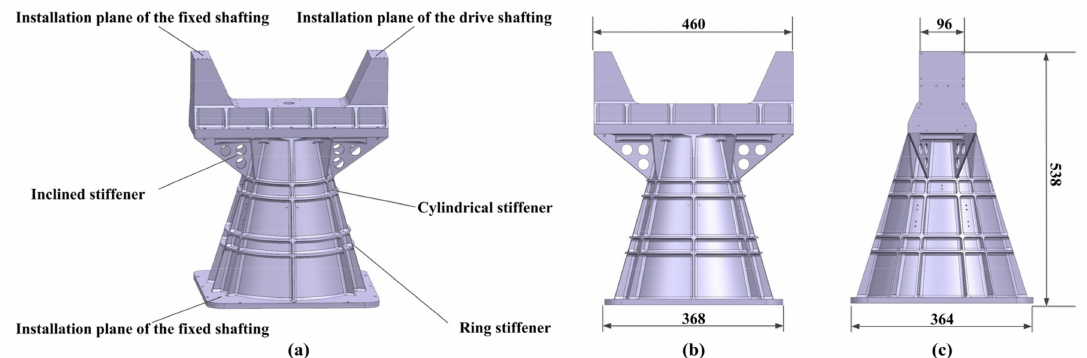
Figure 1. The original structural model of the vertical bracket. ( a ) The structural schematic diagram. ( b ) Front view of the vertical bracket. ( c ) Side view of the vertical bracket.